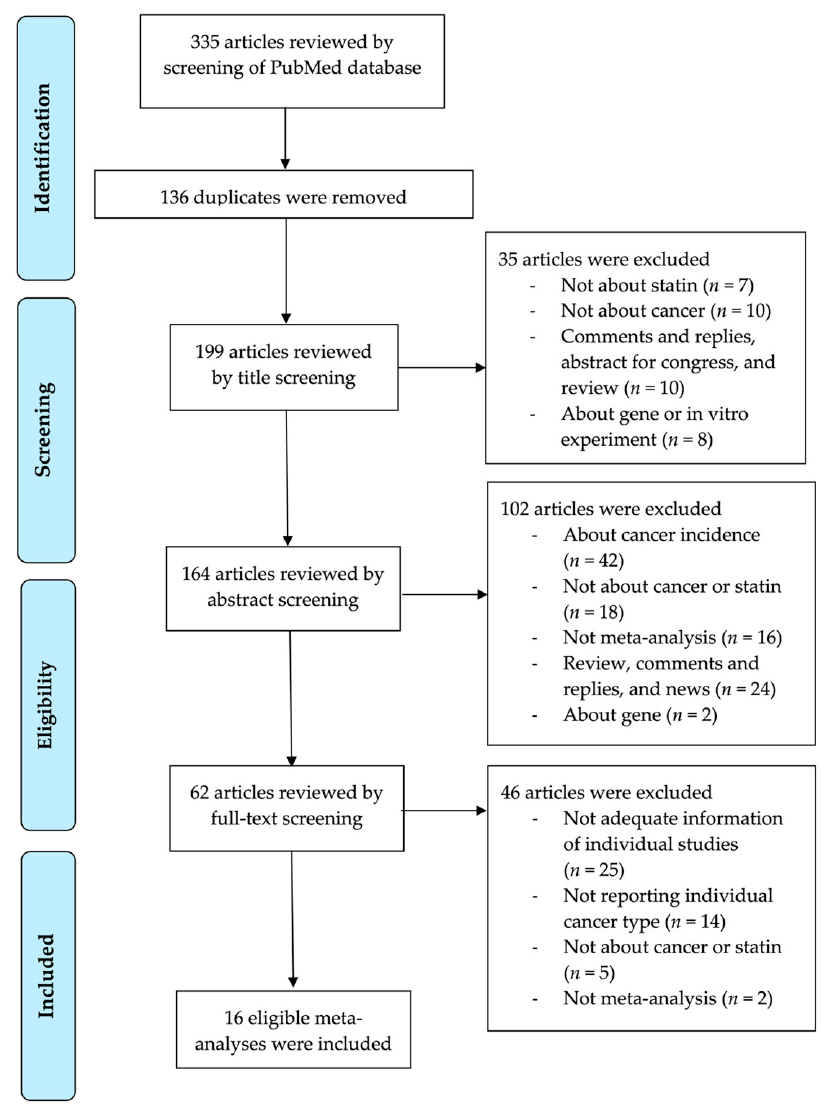
Figure 1. Flow diagram of literature search.